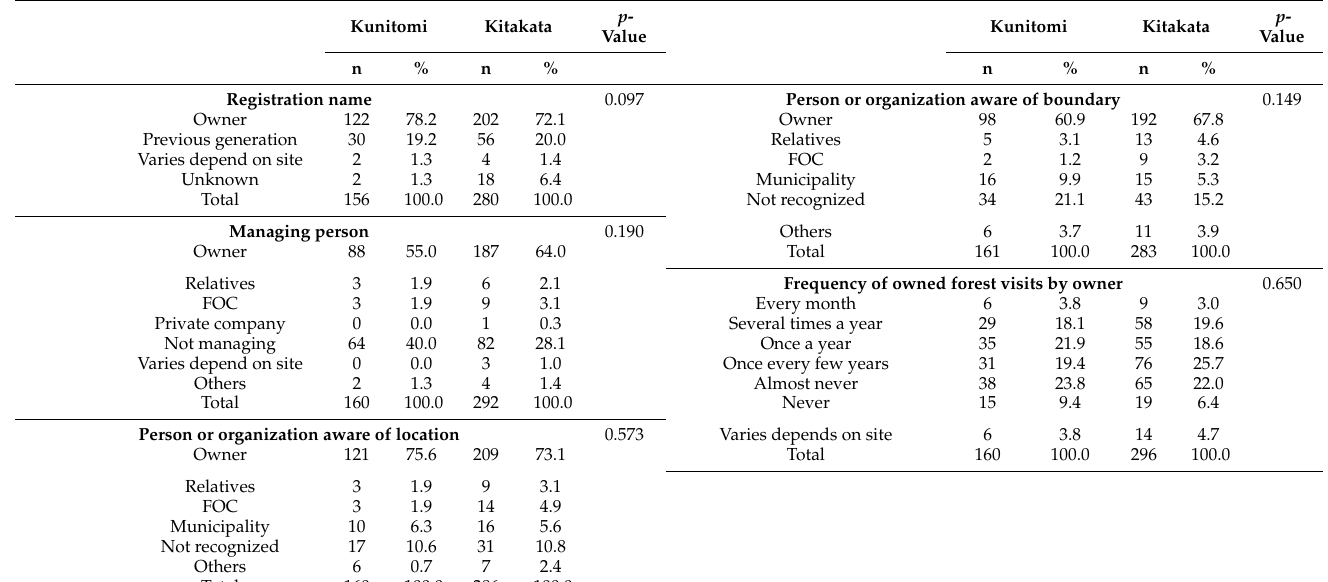
Table A1. Comparison of forest management behaviors between two